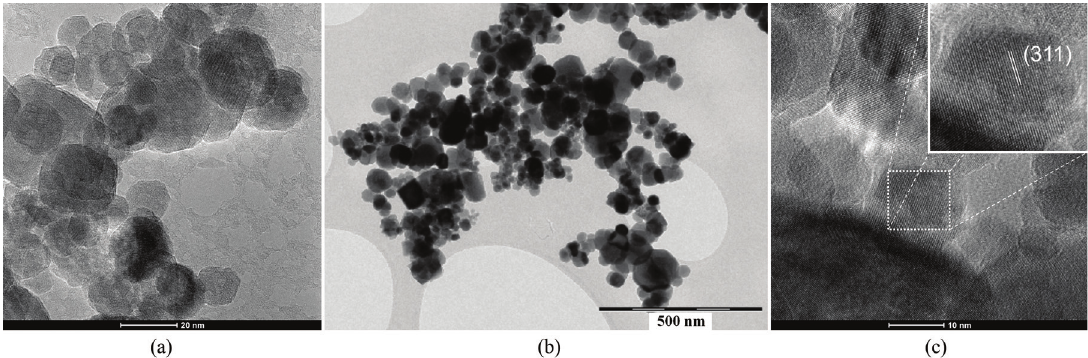
Figure 2. TEM (a-b) and HRTEM (c) images of Fe 15 min. The inset shows crystallographic planes